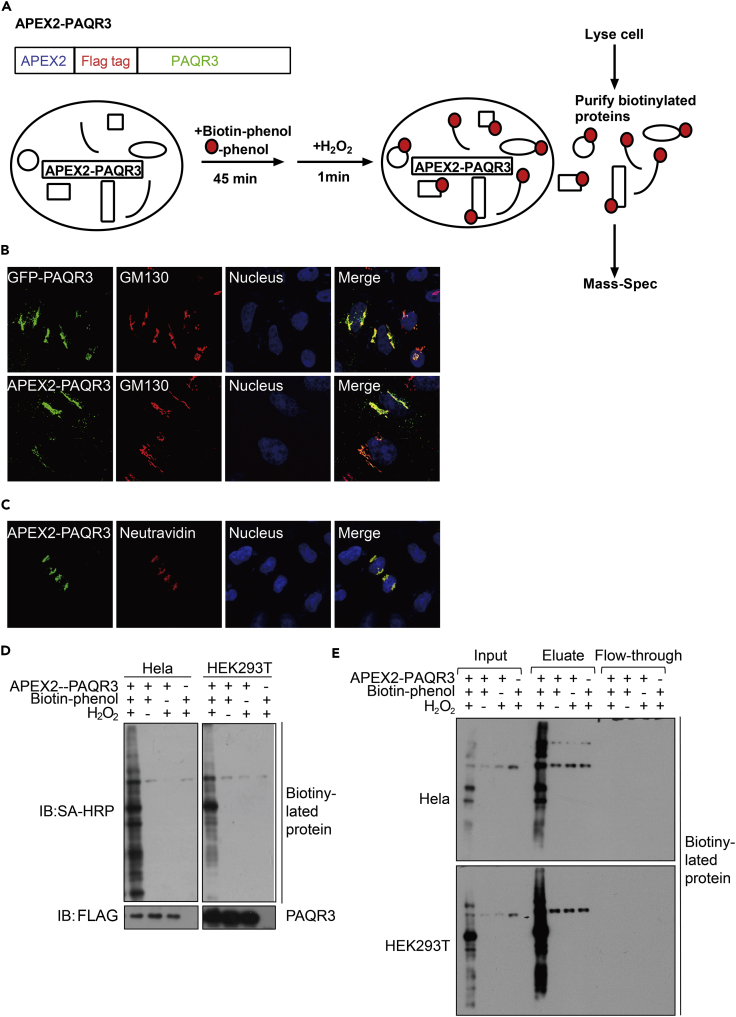
Establishment of Proximity Labeling Using APEX2-PAQR3 Fusion Protein(A) Diagram of the APEX2-PAQR3 labeling strategy. APEX2 and a FLAG tag was fused to the N terminus of PAQR3. On sequential treatment with biotin-phenol and H2O2, proteins in close spatial proximity with PAQR3 would be biotinylated (shown as red dots) and then subjected to mass spectrometry analysis.(B) Subcellular distribution of APEX2-fused PAQR3. HeLa cells were transiently transfected with FLAG-tagged APEX2-PAQR3 or GFP-fused PAQR3. The APEX2-PAQR3 was detected by an antibody against FLAG, followed by immunofluorescent staining. The Golgi was stained with an antibody against GM130, and the nucleus was stained with Hoechst 33342.(C) Subcellular distribution of biotinylated proteins. HeLa cells expressing APEX2-PAQR3 were labeled as in (A) and were stained with a NeutrAvidin-Alexa Fluor 647 (AF647) conjugate to visualize biotinylated proteins. An anti-FLAG antibody was used to visualize APEX-PAQR3.(D) Characterization of APEX-PAQR3-mediated biotinylation of endogenous proteins. Hela and HEK293T cells were transfected with APEX2-PAQR3 and treated with or without biotin-phenol/H2O2. The cell lysate was analyzed by immunoblotting with streptavidin-horseradish peroxidase (SA-HRP). The analysis was repeated three times with similar results.(E) Purification of biotinylated proteins. The proteins as in D were purified by streptavidin chromatography, and the samples were analyzed by immunoblotting with SA-HRP.